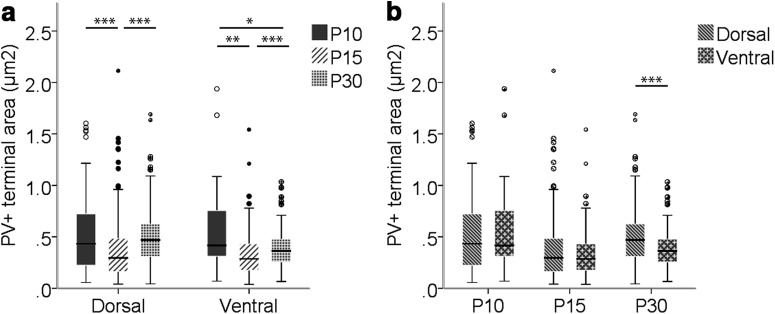
Box-and-whisker plots of the cross-sectional area of PV+ terminals at P10, P15, and P30 in dorsal and ventral MEC LII. a, Changes during development of the cross-sectional area of PV+ terminals in dorsal and ventral MEC LII. b, Dorsoventral differences per time point. The middle bar of each box plot represents the population median, and the 25th and 75th percentiles are represented by the lower and upper boundaries of the boxes, respectively. The minimum and maximum values are represented by the lower and upper ends of the whiskers. Dots represent outliers, i.e., values that exceeded the 75th percentile + 1.5 × (75th percentile – 25th percentile). *, p ≤ 0.05; **, p ≤ 0.01; ***, p ≤ 0.001.